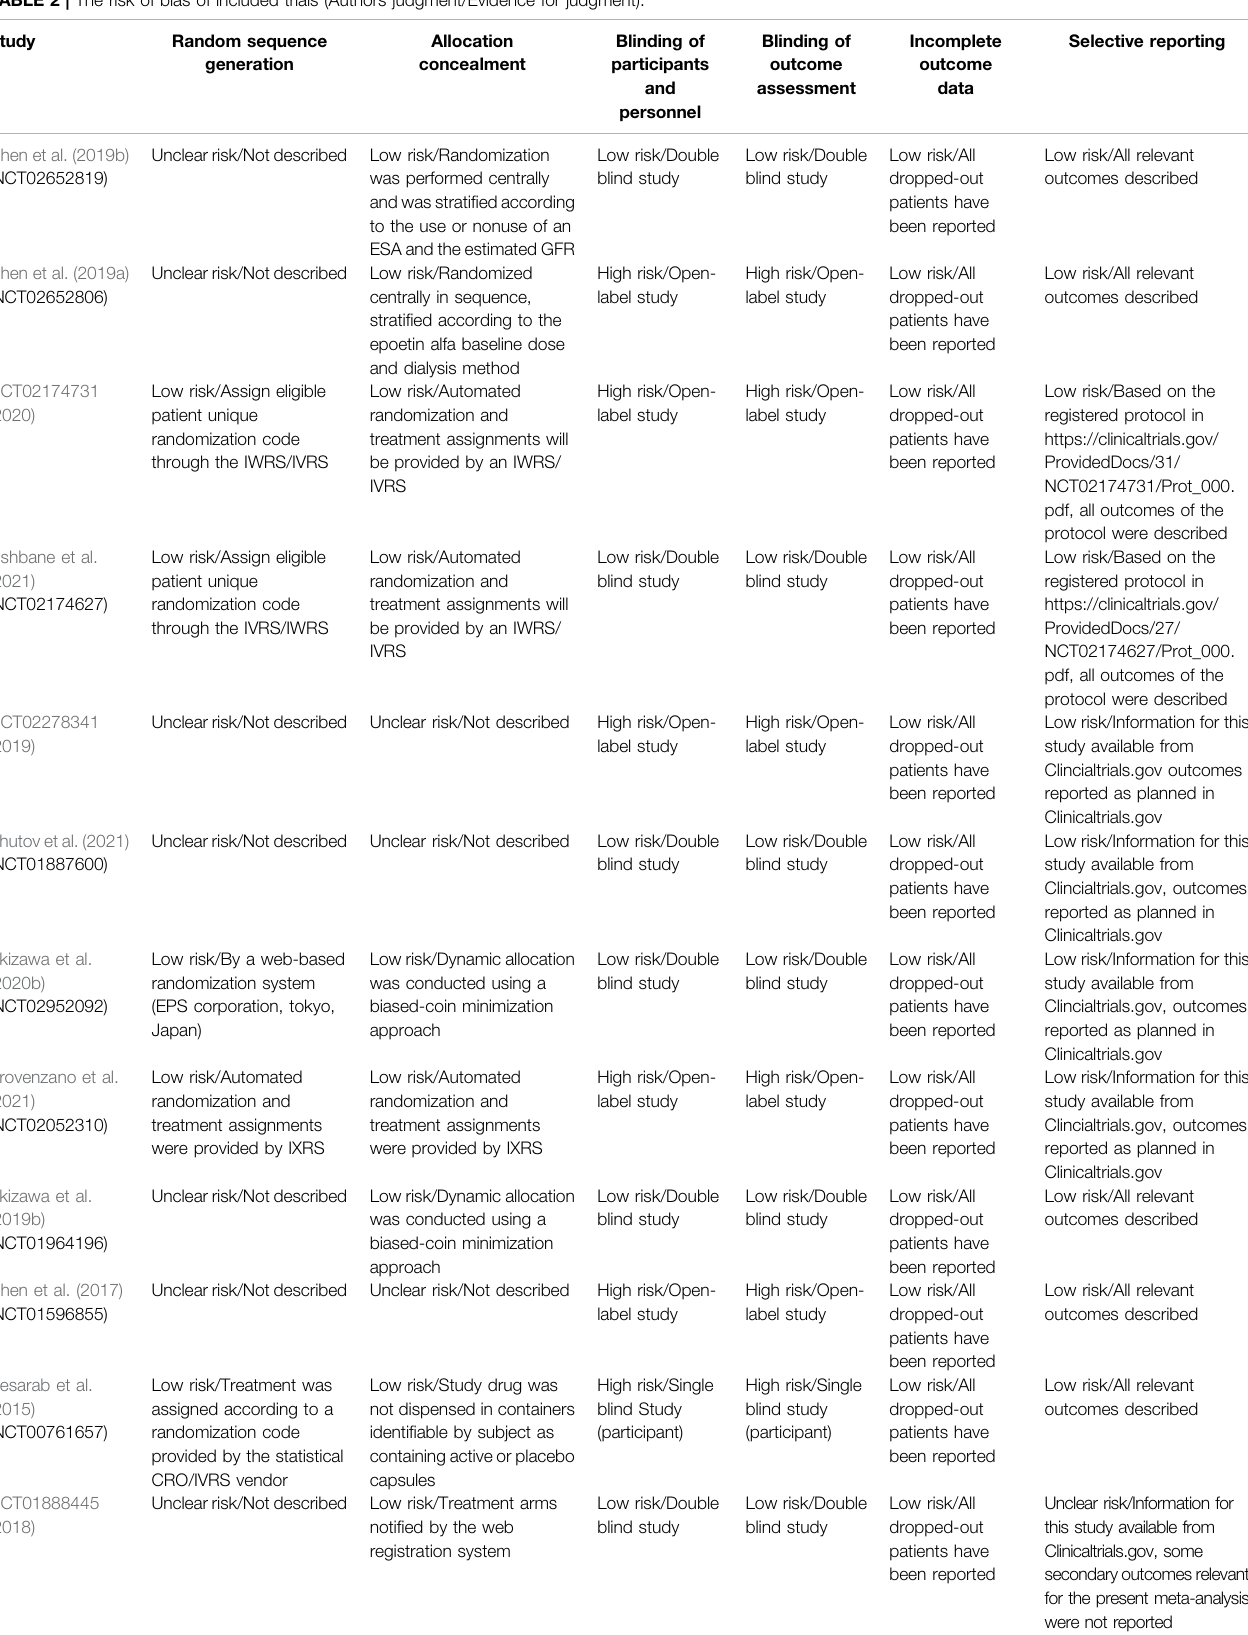
TABLE 2 | The risk of bias of included trials (Authors judgment/Evidence for